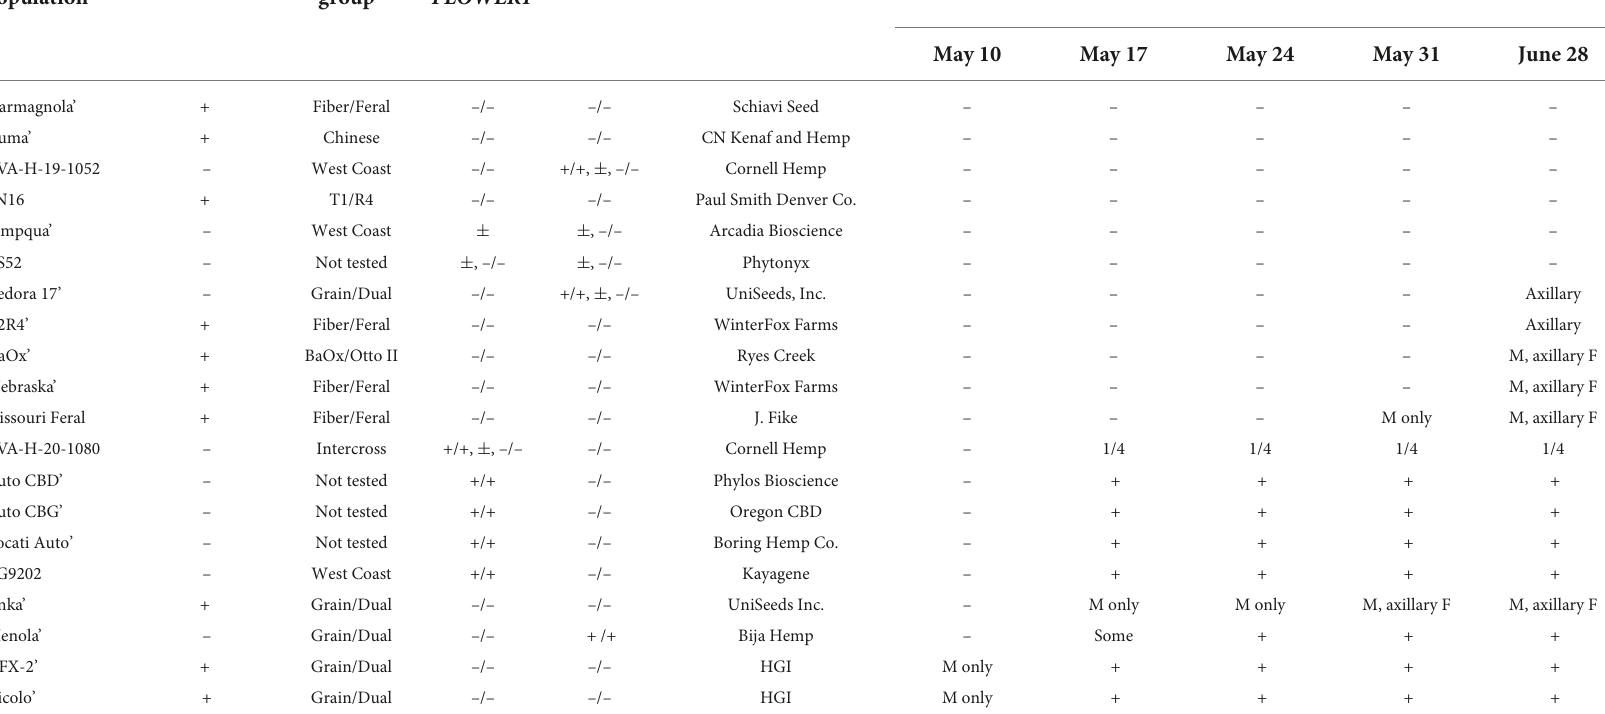
TABLE 3 Time to flower of various C. sativa cultivars and populations under continuous light. Cultivar or